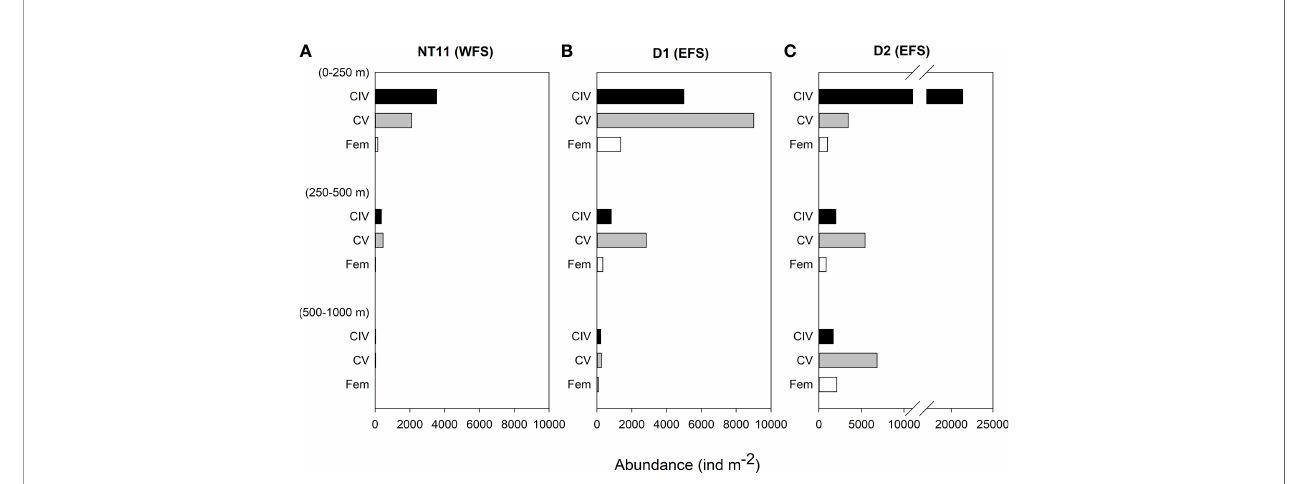
FIGURE 4 | Calanus fi nmarchicus : depth distribution of CIV, CV, and females in depth-strati fi ed MOCNESS samples at (A) station NT11, (B) station D1, and (C) station D2. See Table 1 for station location